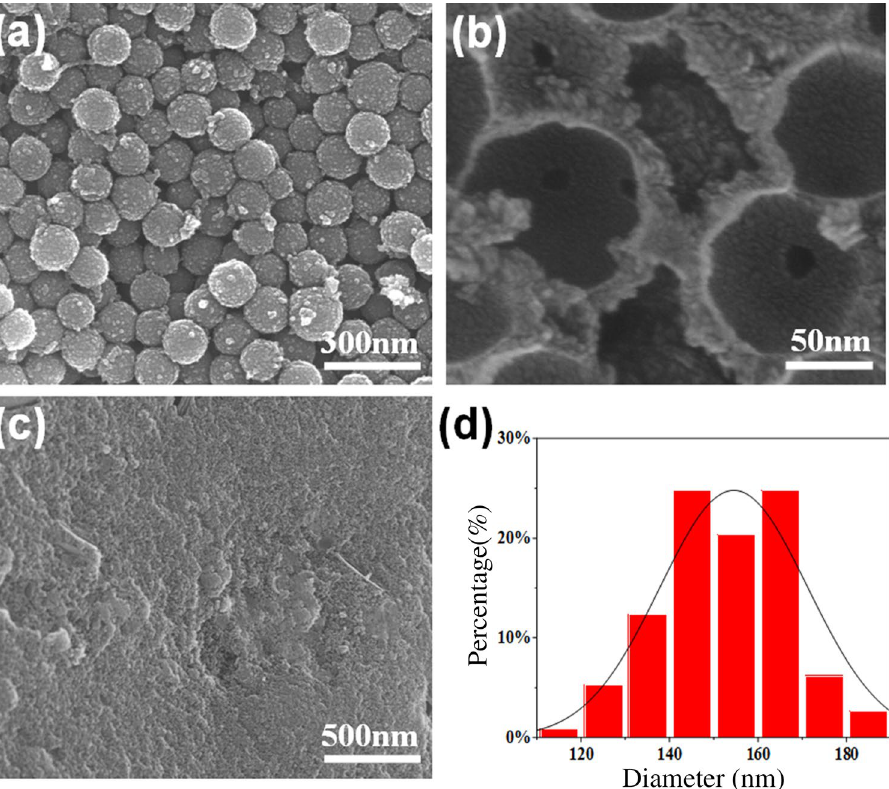
Figure 2. SEM graphs of ( a ) R-SiO 2 @xDCX-24 nanoarticles, ( b ) HPP-24, ( c ) SiO 2 @xDCX-24 nanoarticles, and ( d ) size distribution analysis of R-SiO 2 @xDCX-24